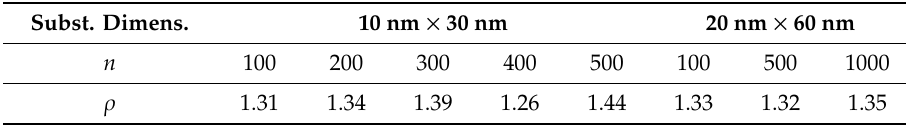
Table 1. Density ρ (g / cm 3 ) of films deposited on the small and large substrate clusters (Figures 2 and 3); n is the number of injection steps between subsequent alternations of the deposition angle. Subst.